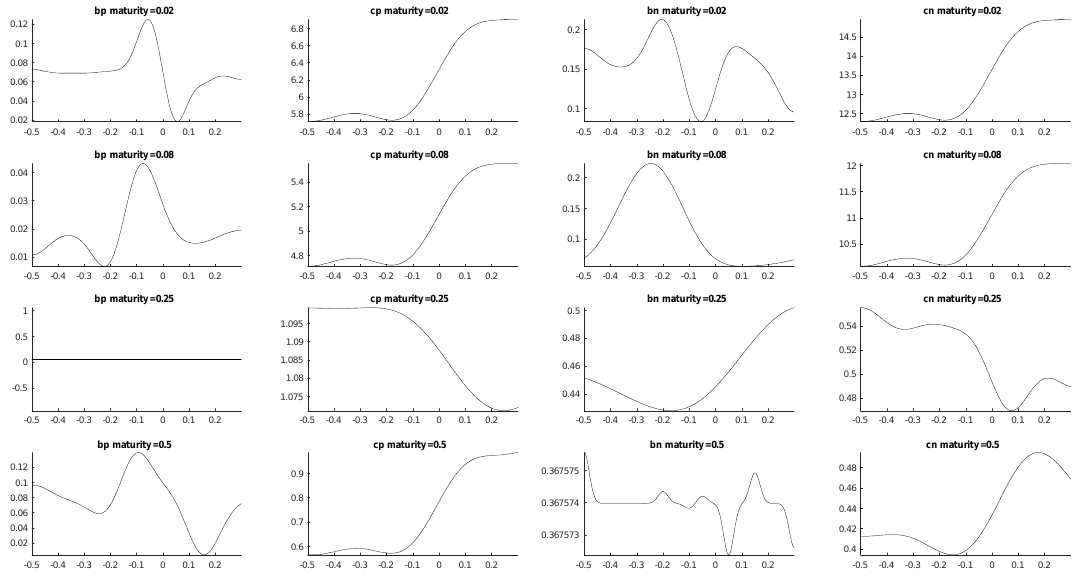
Figure 10. Estimated dependence of the four bilateral gamma parameters on moneyness for the first four maturities.